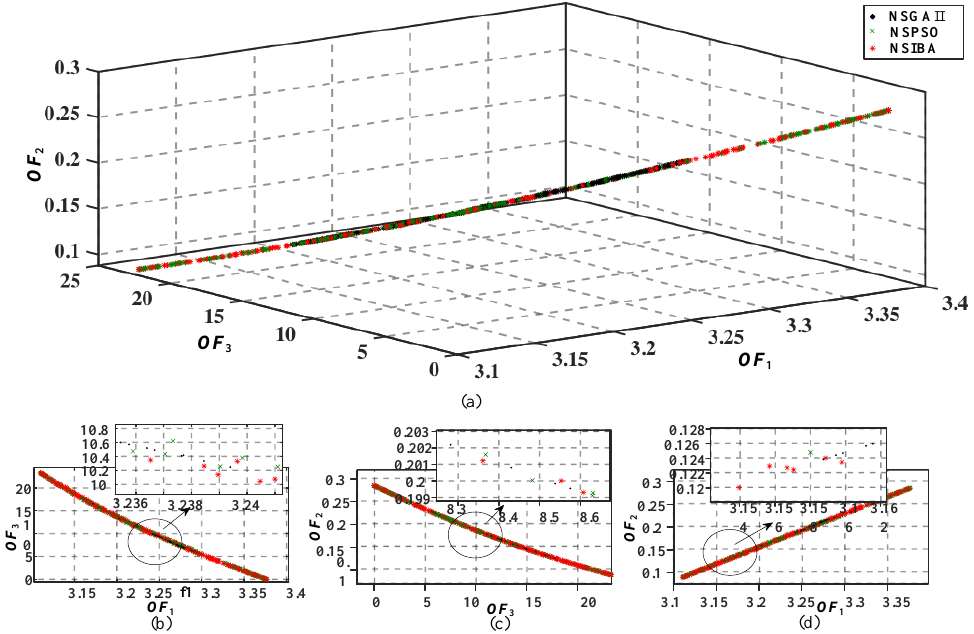
Figure 7. Pareto optimal fronts: ( a ) three-dimensional diagram, ( b ) vertical view, ( c ) vront view, ( d ) end view.